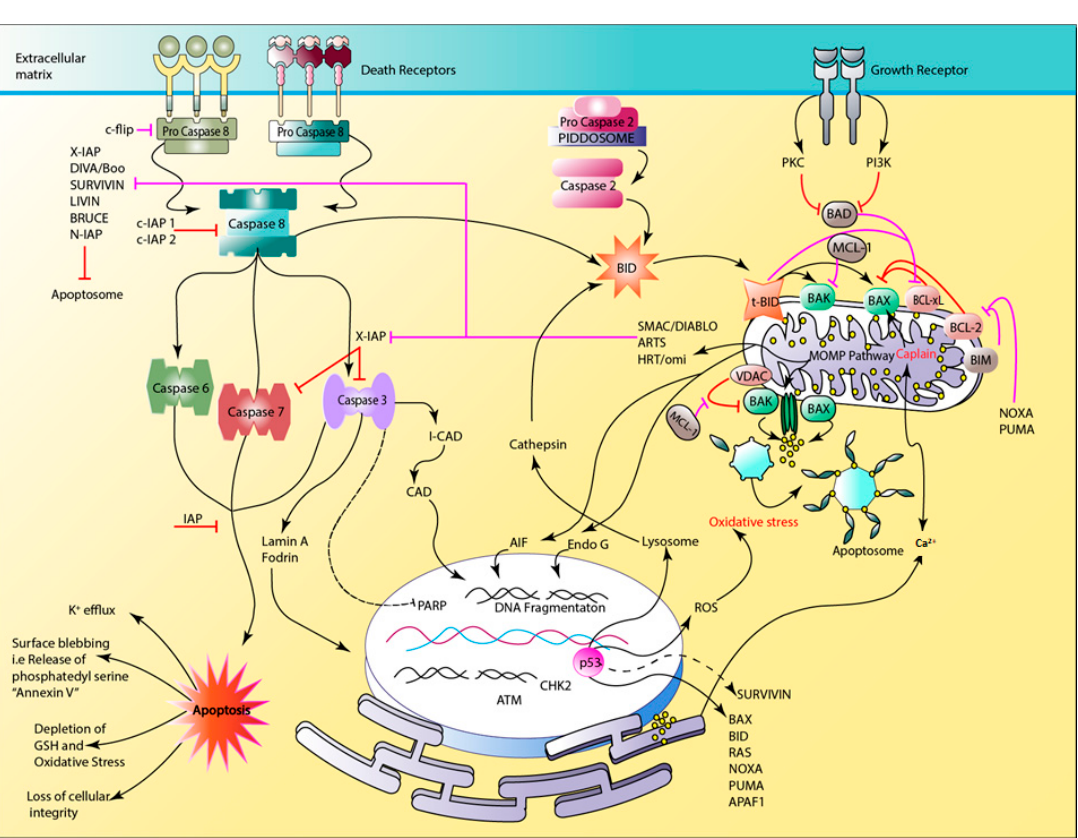
Figure 3. Illustration of intrinsic, extrinsic, mitochondrial, and endoplasmic reticulum apoptotic pathways. The role of apoptotic proteins (black arrows), and their inhibition by anti-apoptotic proteins (Red) which are regulated by apoptotic inhibitors (Pink). An apoptotic cell is usually characterized by increased K + efflux, surface blebbing, depletion of anti-oxidative markers such as GSH, chromatin condensation, and loss of cellular integrity.